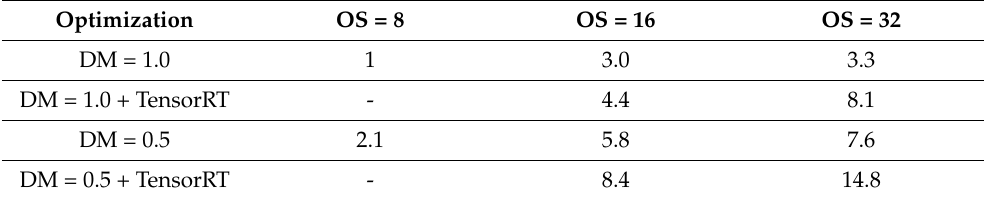
Table 10. Variation in inference time with respect to different parameterisations when compared to the baseline configuration.